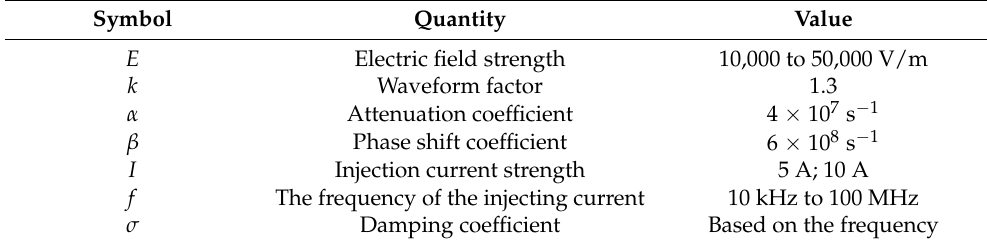
Based on the frequency The frequency of the injecting current By comparing the signal of the controller under the two test methods, the two are equivalent to the controller terminal under the electromagnetic pulse effect test. When the pulse current is injected into the main fuel regulation control system, the coupling effect of the system can be obtained by monitoring the differential mode voltage of the controller